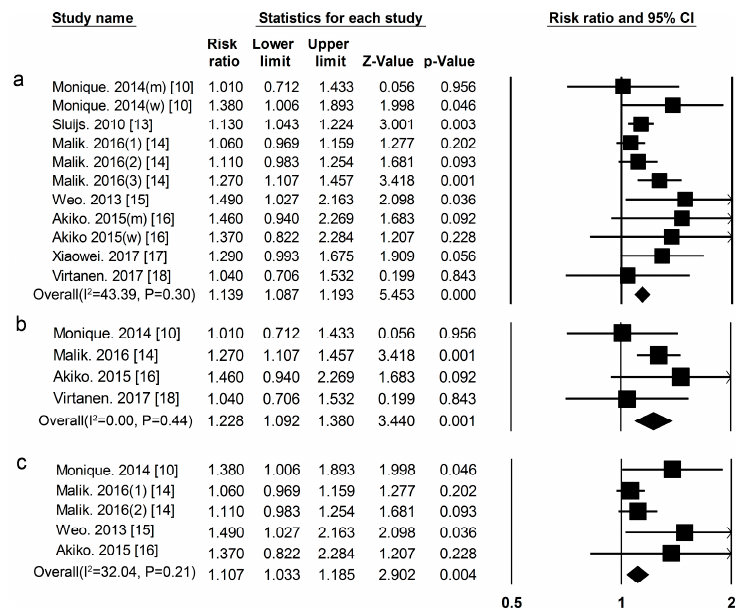
Figure 3. Animal protein and type 2 diabetes RRs for ( a ) the highest vs. the lowest intake in all subjects and ( b ) the highest vs. the lowest intake in men ( c ) the highest vs. the lowest intake in women. The RR of each study is represented by a square, 95% CI are represented by the horizontal lines, and the diamond represents the estimate and its 95% CI.